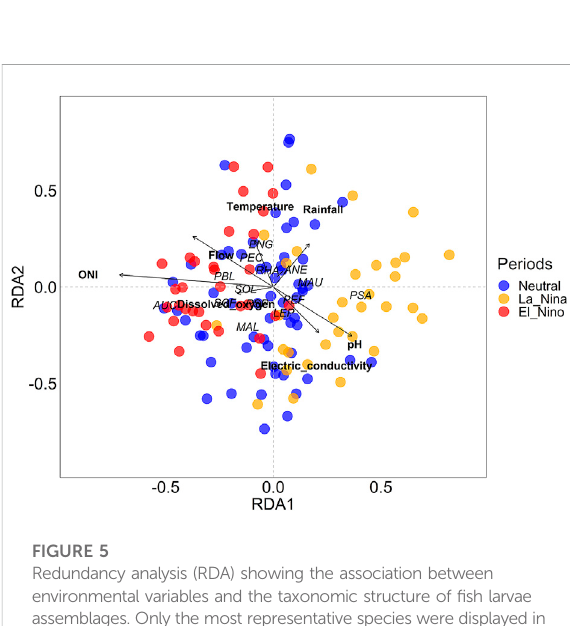
FIGURE 5 Redundancy analysis (RDA) showing the association between environmental variables and the taxonomic structure of fi sh larvae assemblages. Only the most representative species were displayed in the graph. A detailed list of species is available in Supplementary Material S1 and their abbreviations are in the legend of Figure